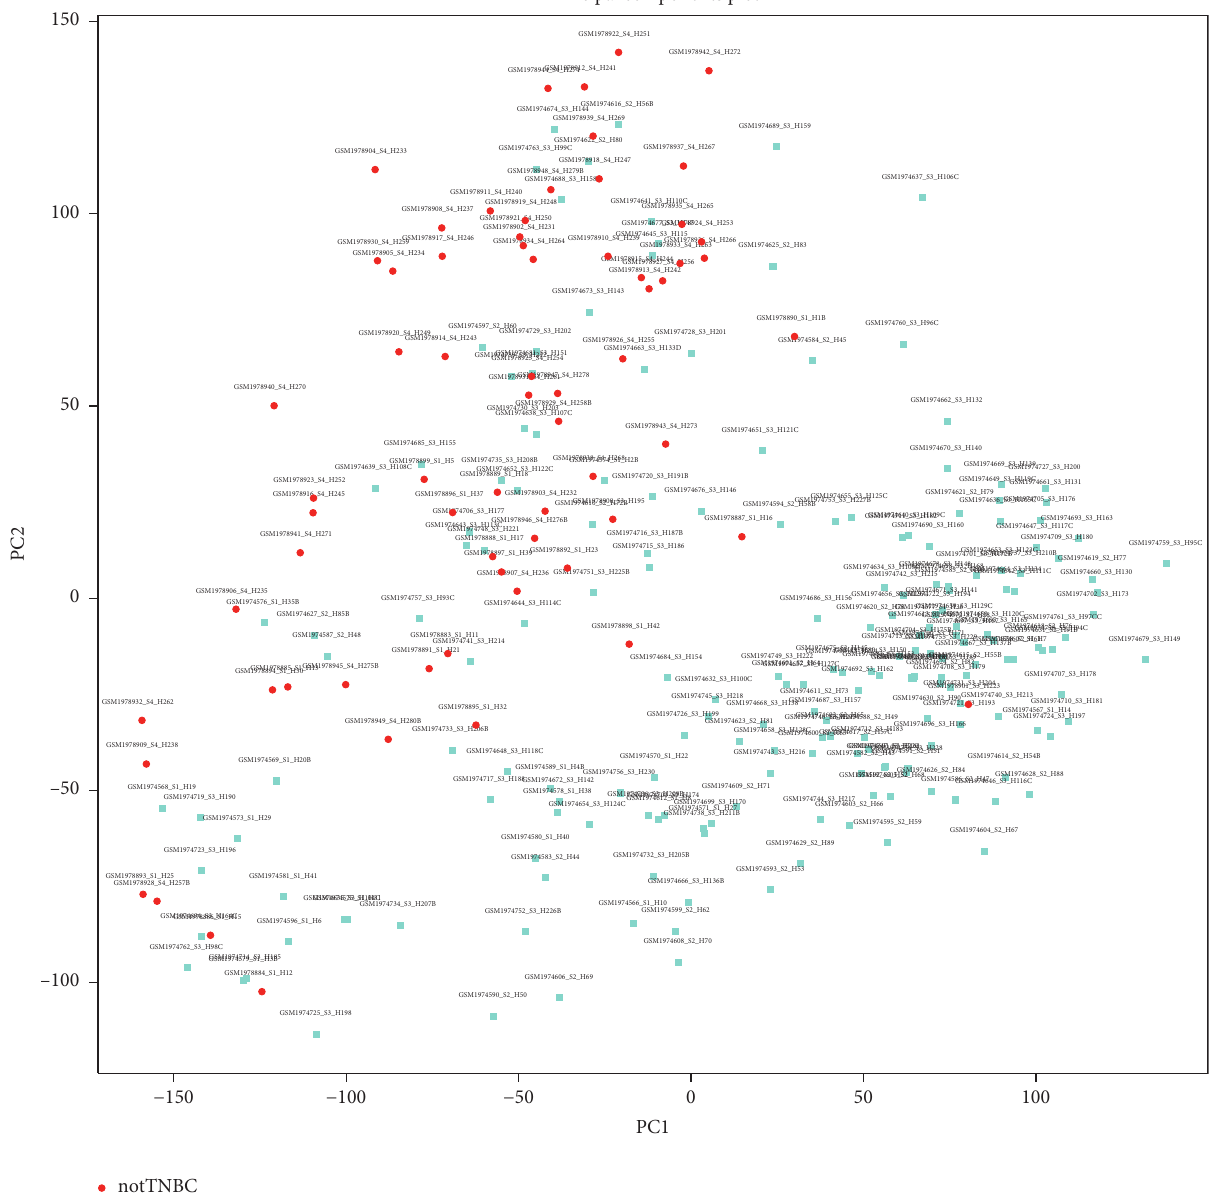
Figure 4: PCA differential expression